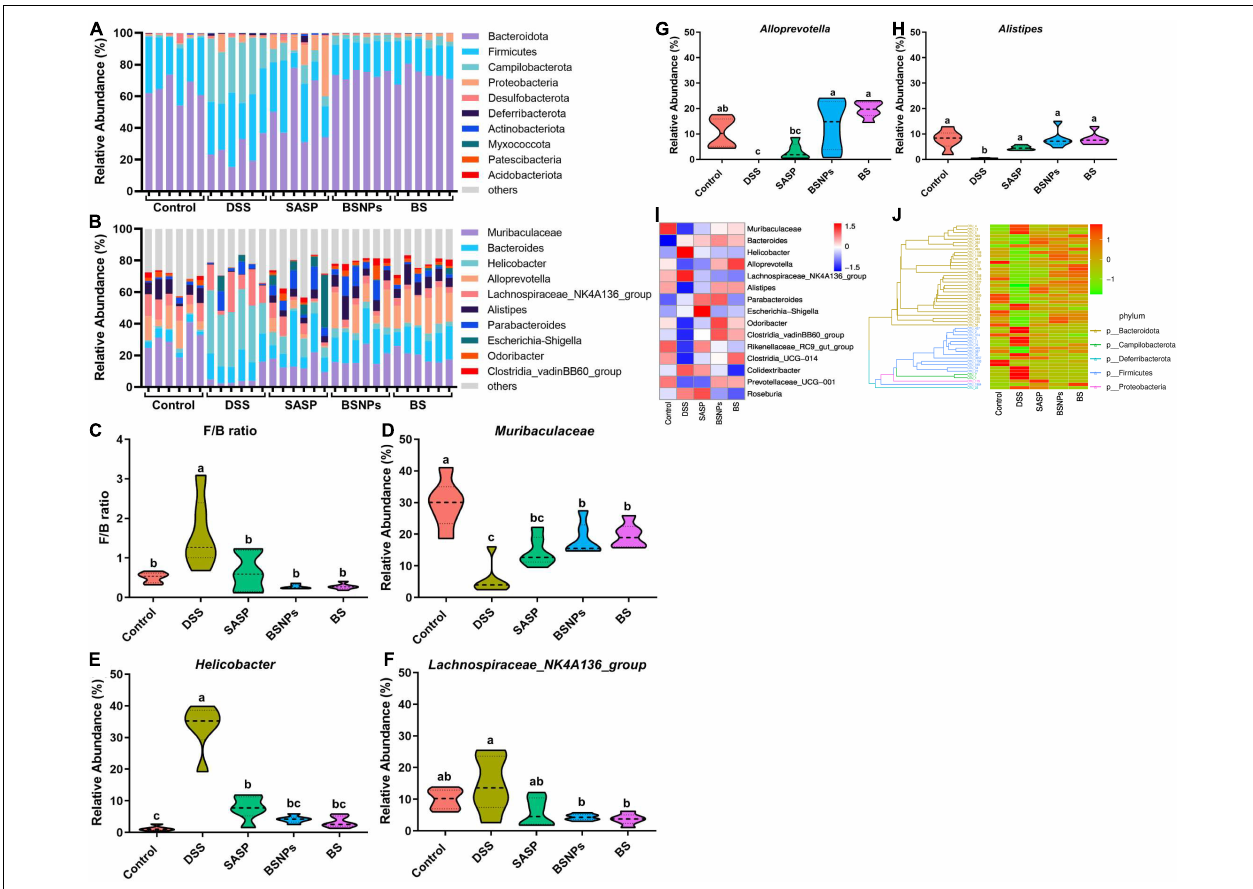
FIGURE 4 | Analysis of the microbial community structure of each group. (A) Relative abundance of each sample at the phylum level. (B) Relative abundance of each sample at the genus level. Violin plots showing Firmicutes to Bacteroidetes ratio (F/B ratio) (C) of each group, and relative abundance of Muribaculaceae (D) , Helicobacter (E) , Lachnospiraceae_NK4A136_group (F) , Alloprevotella (G) , and Alistipes (H) at the genus levels. (I) Heatmap illustrating the relative abundance of the 15 most abundant bacterial genus. (J) Phylogenetic tree and heatmap showing relative abundances of operational taxonomic units (OTUs) together with a corresponding phylogenetic tree. The clustering branch represents different bacterial phyla. The abundance graph was shown on the right, which corresponds to the abundance of left OTUs in each sample. Means without a common letter are significantly different at p < 0.05 using one-way ANOVA followed by Tukey’s test for post hoc